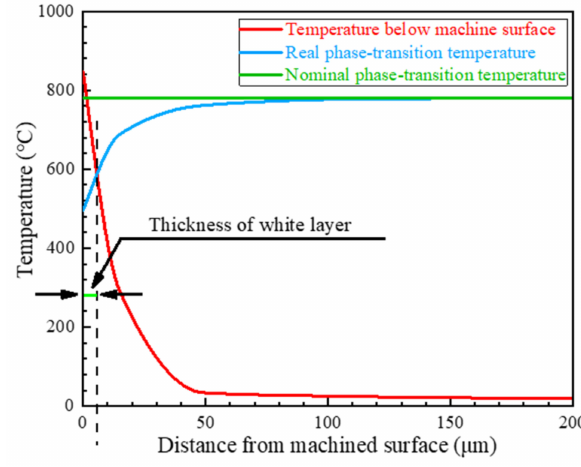
Figure 1. Prediction model of the white-layer